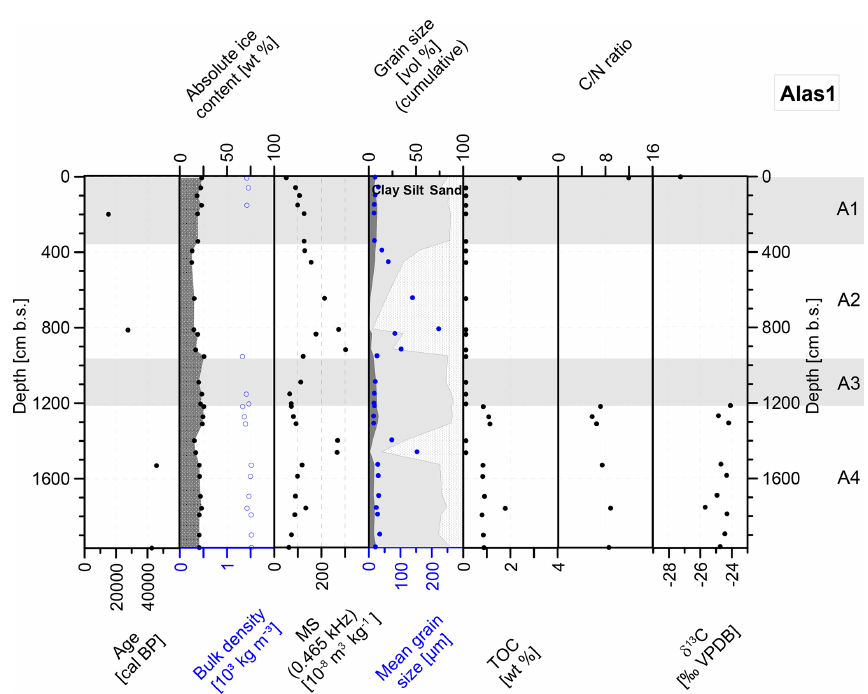
Figure 6. Characteristics of the Alas1 core: radiocarbon ages, absolute ice content, bulk density, magnetic susceptibility (MS), grain size composition, mean grain size, total organic carbon (TOC) content, carbon/nitrogen (C / N) ratio and stable carbon isotope ( δ 13 C) ratio. The gray and white areas mark the different stratigraphic units (A1 to A4).